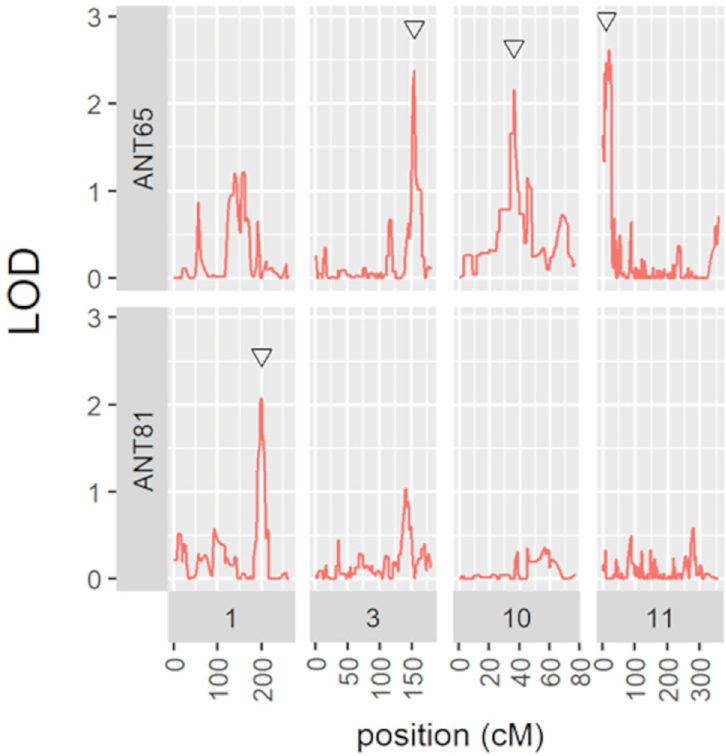
Fig 3. Quantitative resistance loci (QRL) plots indicating the LOD score values for each marker position. Manhattan LOD scores obtained by multiple interval mapping analysis (y) using the molecular marker distances of the AM genetic map for C . lindemuthianum races 65 and 81. Black triangles indicate the position of significant QRL.